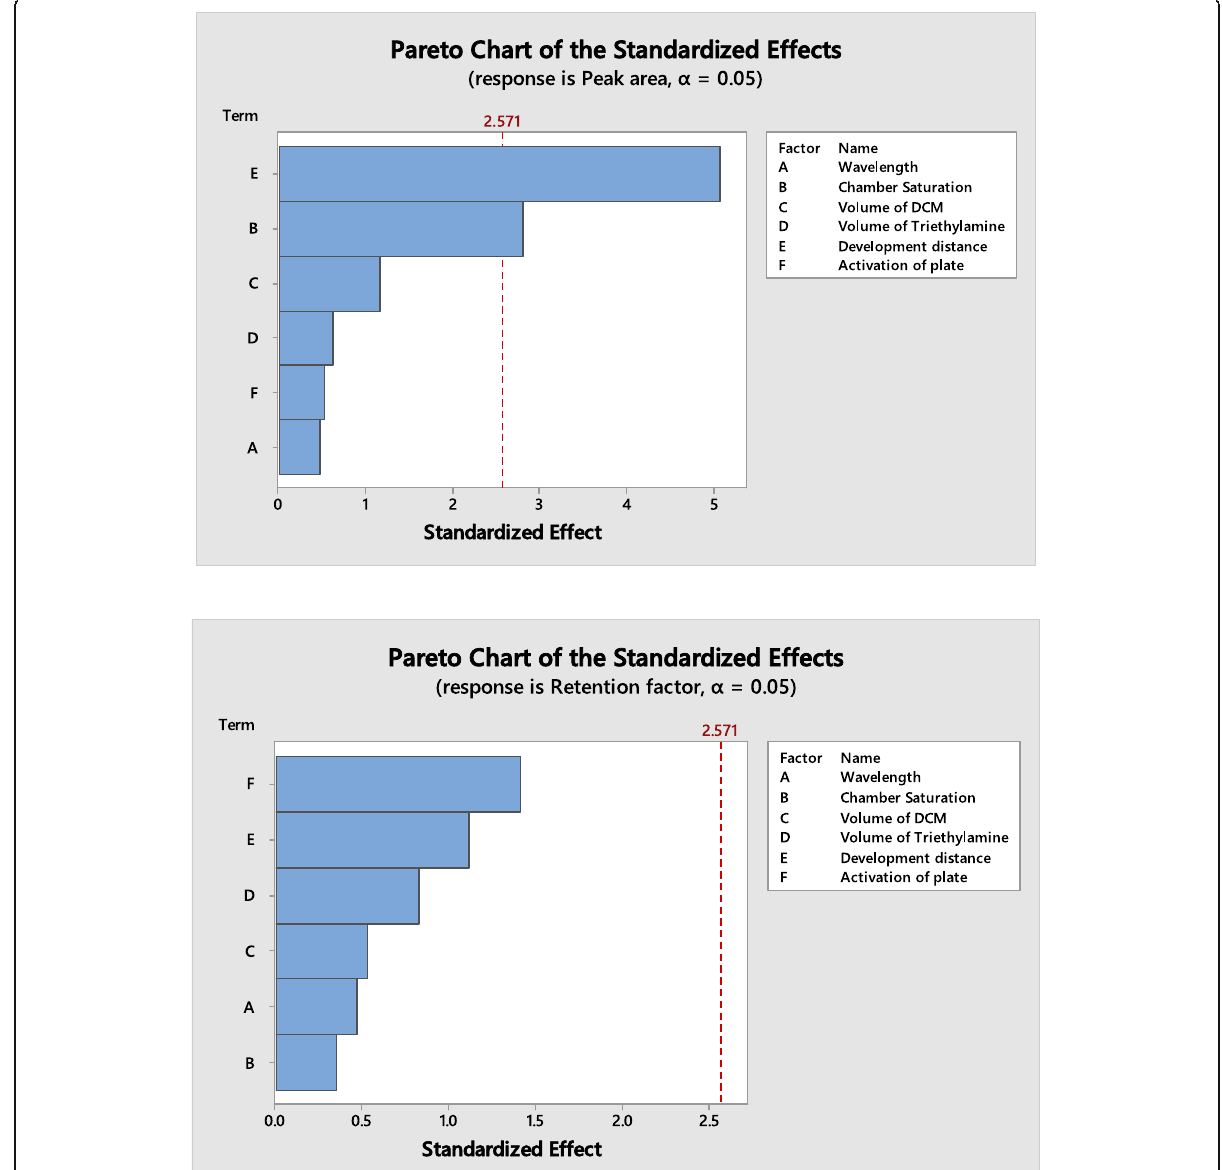
Fig. 2 Pareto chart of the standardized effects for peak area and retention